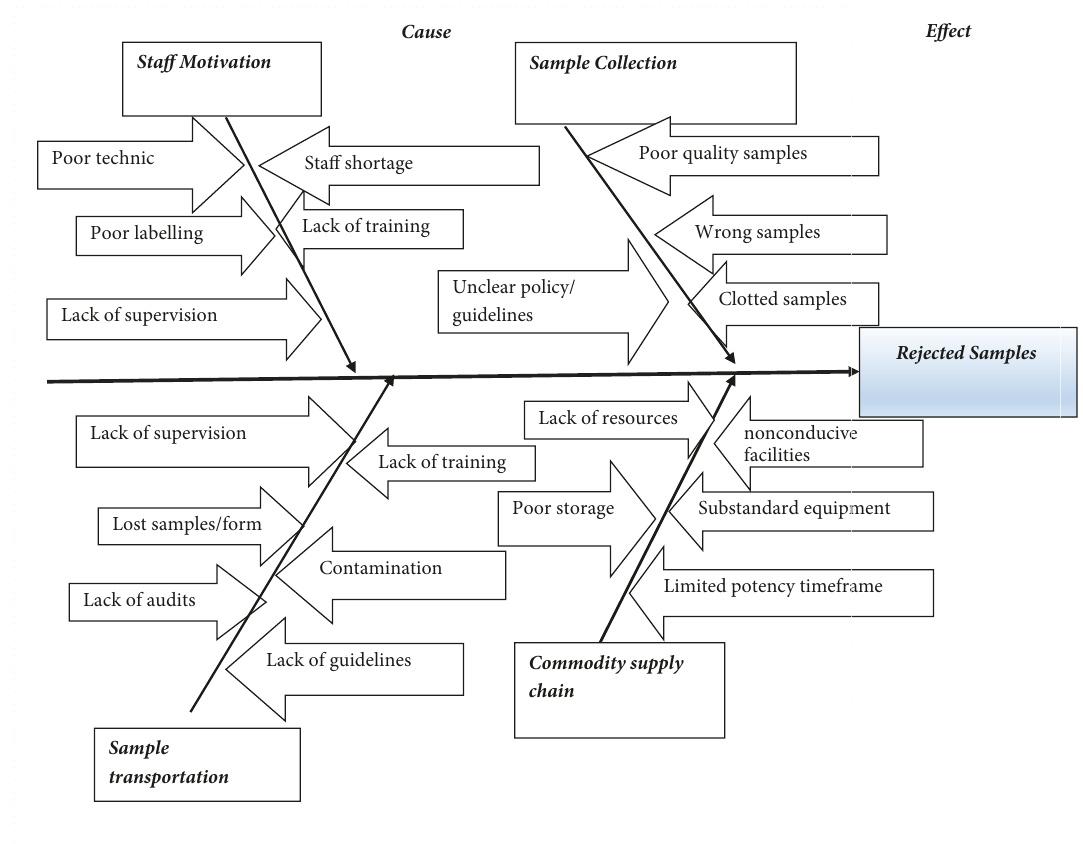
Figure 2: Ishikawa for EID sample management, Mashonaland West Province, Zimbabwe,